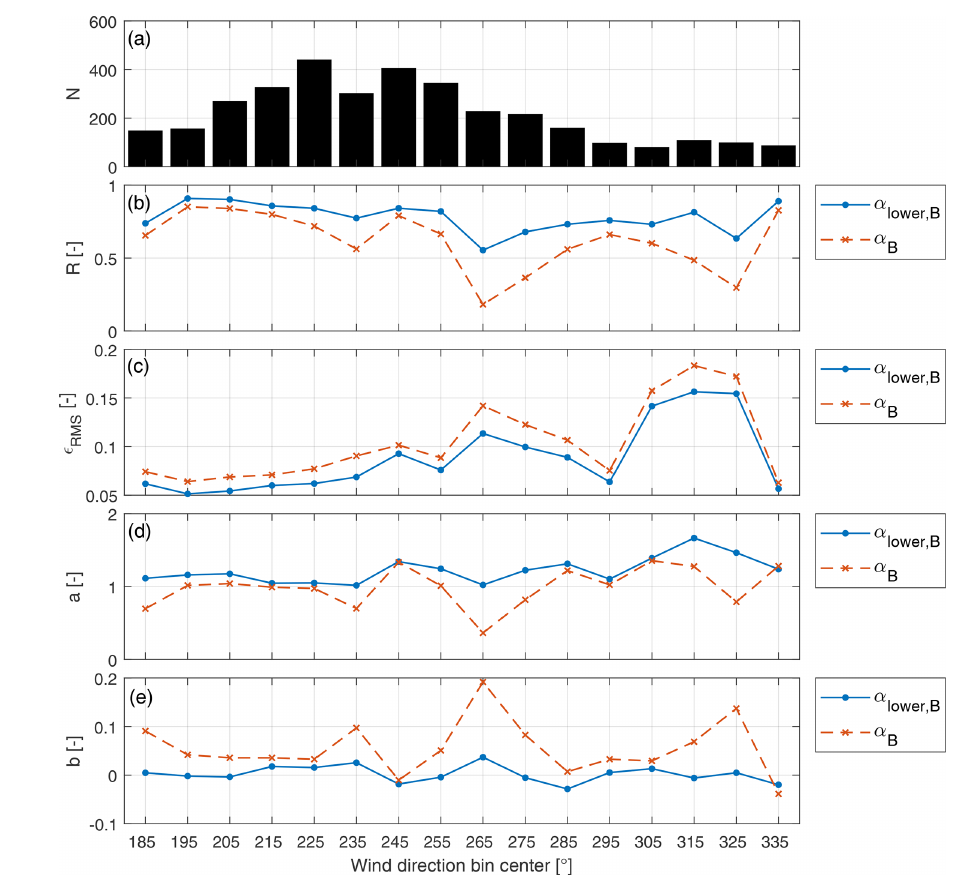
Figure 10. Statistics of the shear estimates as functions of wind direction. Blue solid line: lower-half-rotor shear; red dashed line: full-rotor shear. (a) Number of 10min data points; (b) Pearson correlation coefficient; (c) root-mean-squared errors; (d, e) linear best-fit coefficients ( y = ax + b ).